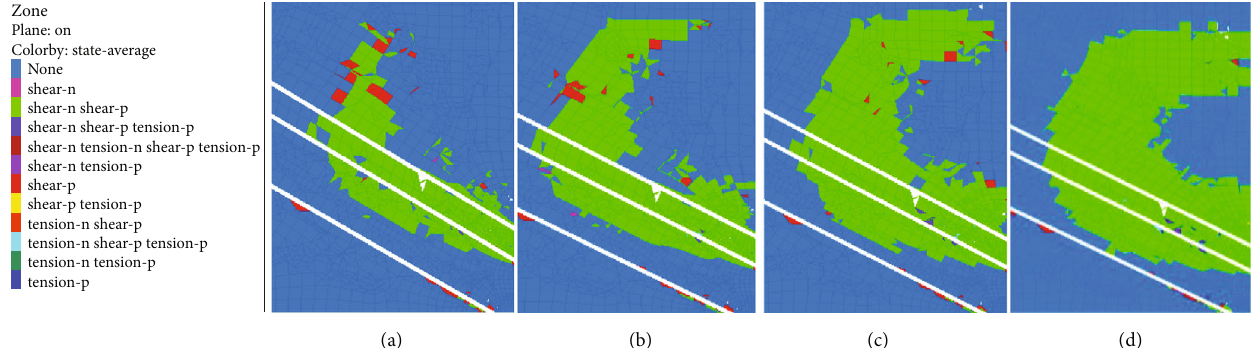
Figure 18: The change of plastic zone in two sides of roadway in 302 mining area when the cutting position is 340m ahead of schedule. (a) Working face advancing 40m; (b) working face advancing 80 m; (c) working face advancing 120m; (d) working face advancing 160 m.